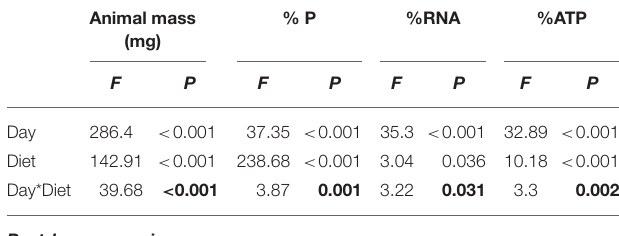
TABLE 1 | Daphnid mass and P, RNA, and ATP content for animals grown on different C:P diets for 3, 6, 10, and 14 days. Animal mass (mg)